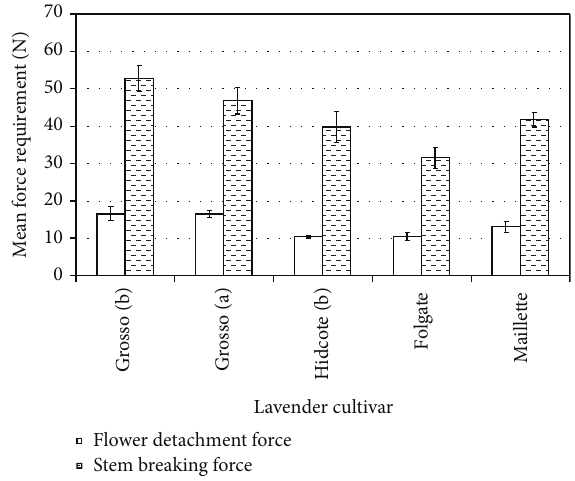
Figure 7: Mean flower detachment force and stem tensile failure force for five lavender cultivars normalized to a moisture content of 58% wet basis showing 95% confidence